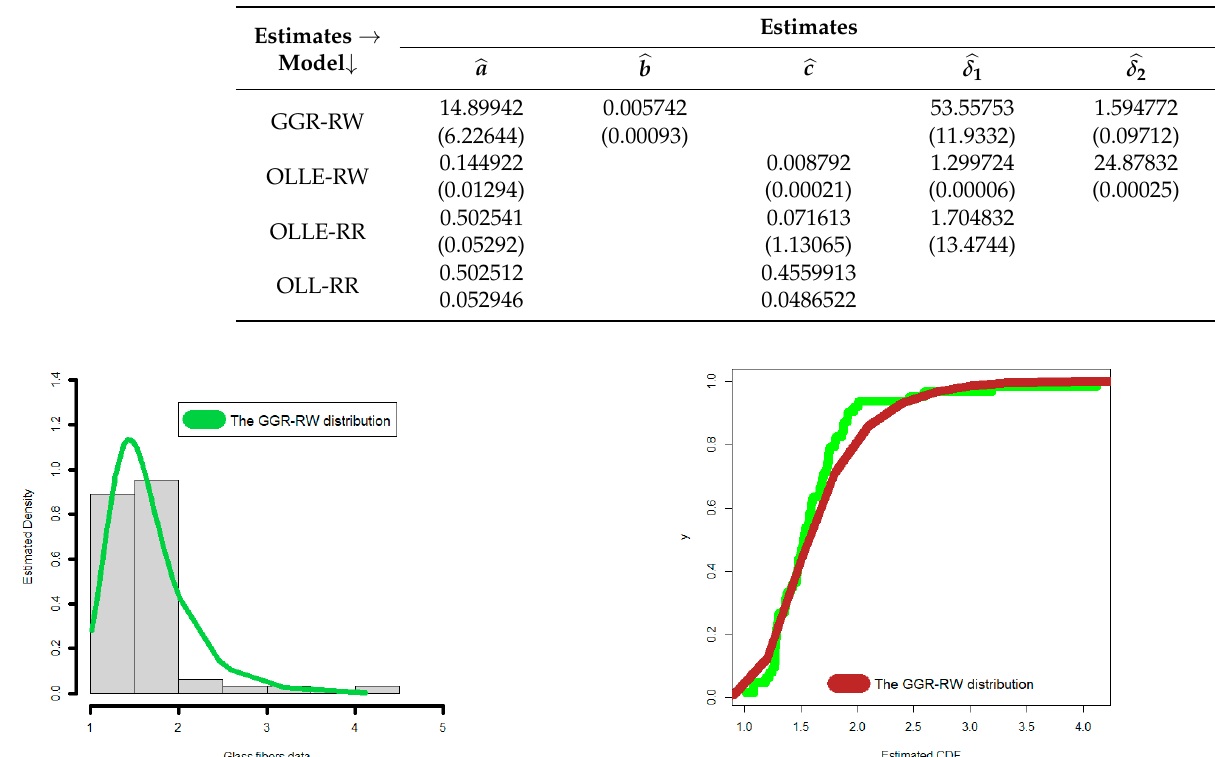
Figure 5. Estimated PDF (left) and CDF (right) for the glass fibers data.